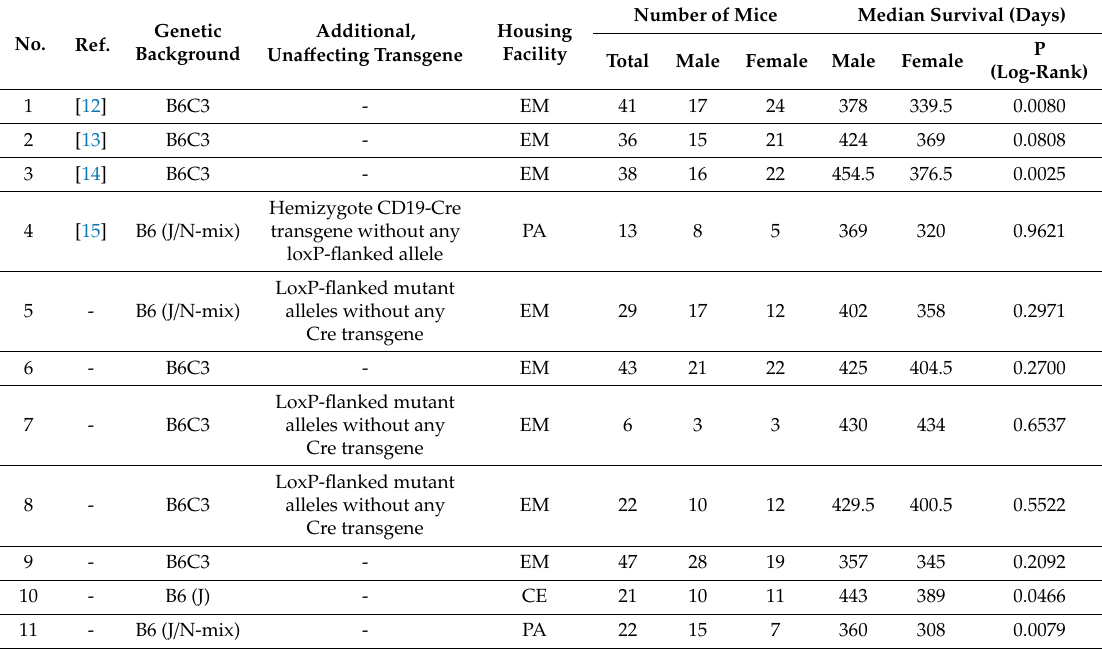
Table 1. Characteristics of the analyzed E µ -TCL1 tg / wt